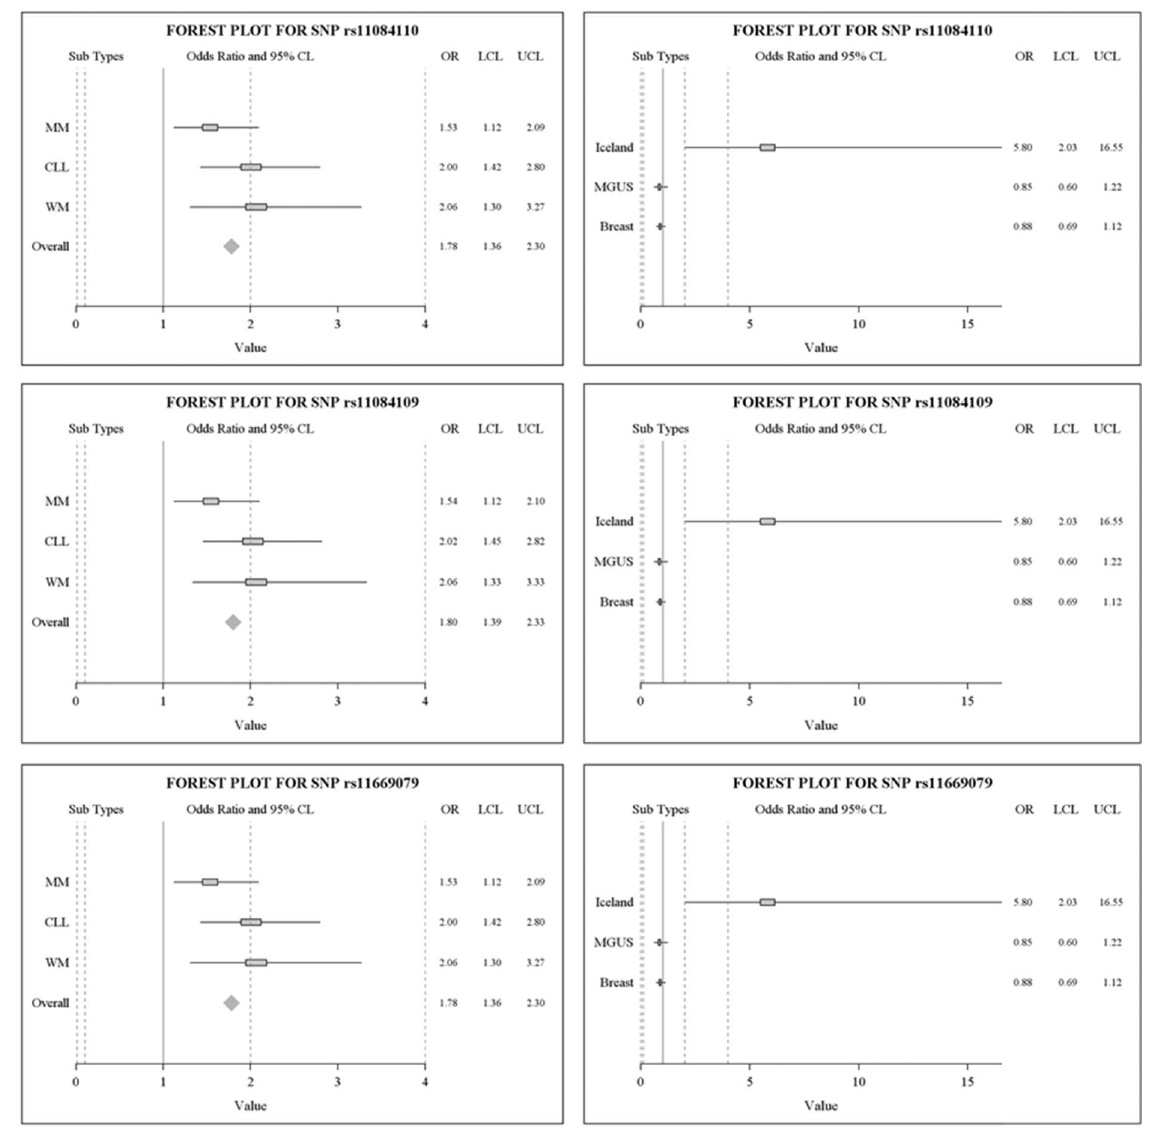
Figure 2. Forest plots of three linked SNPs in B-cell Malignancies, the Icelandic kindred, breast cancer and MGUS. The left column of three panels show the odds ratios of B cell malignancy for the three linked intronic HAS1 SNPs. The OR denotes the odds of having the minor allele as assessed by genotype. The X-axis corresponds to odds ratio. The horizontal line represents 95% confidence interval. Each box represents the OR point estimate. The diamond represents the odds ratios obtained from pooled analysis with 95% confidence interval. Each group is compared to the appropriate control group. The right column of three panels show odds ratios for the Icelandic kindred, MGUS and breast cancer; each individual group is compared to its own control group as indicated in results. The cumulative risks were not estimated for these last three groups as they are unrelated to each other. These plots show that there were no associations of risk with the three linked SNPs for sporadic MGUS or breast cancer. There was a very strong association of the minor allele with risk for the B cell malignancies (pooled OR=1.78) and the Icelandic Kindred (OR=5.8). Note difference in scale values between panels in the two columns.